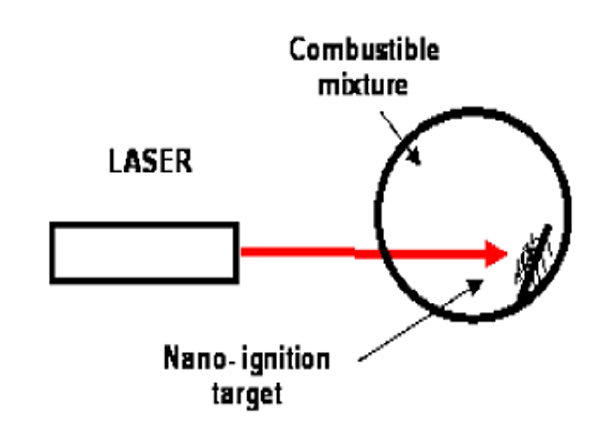
Figure 9: Laser ignition system using a target coated with SWCNTs